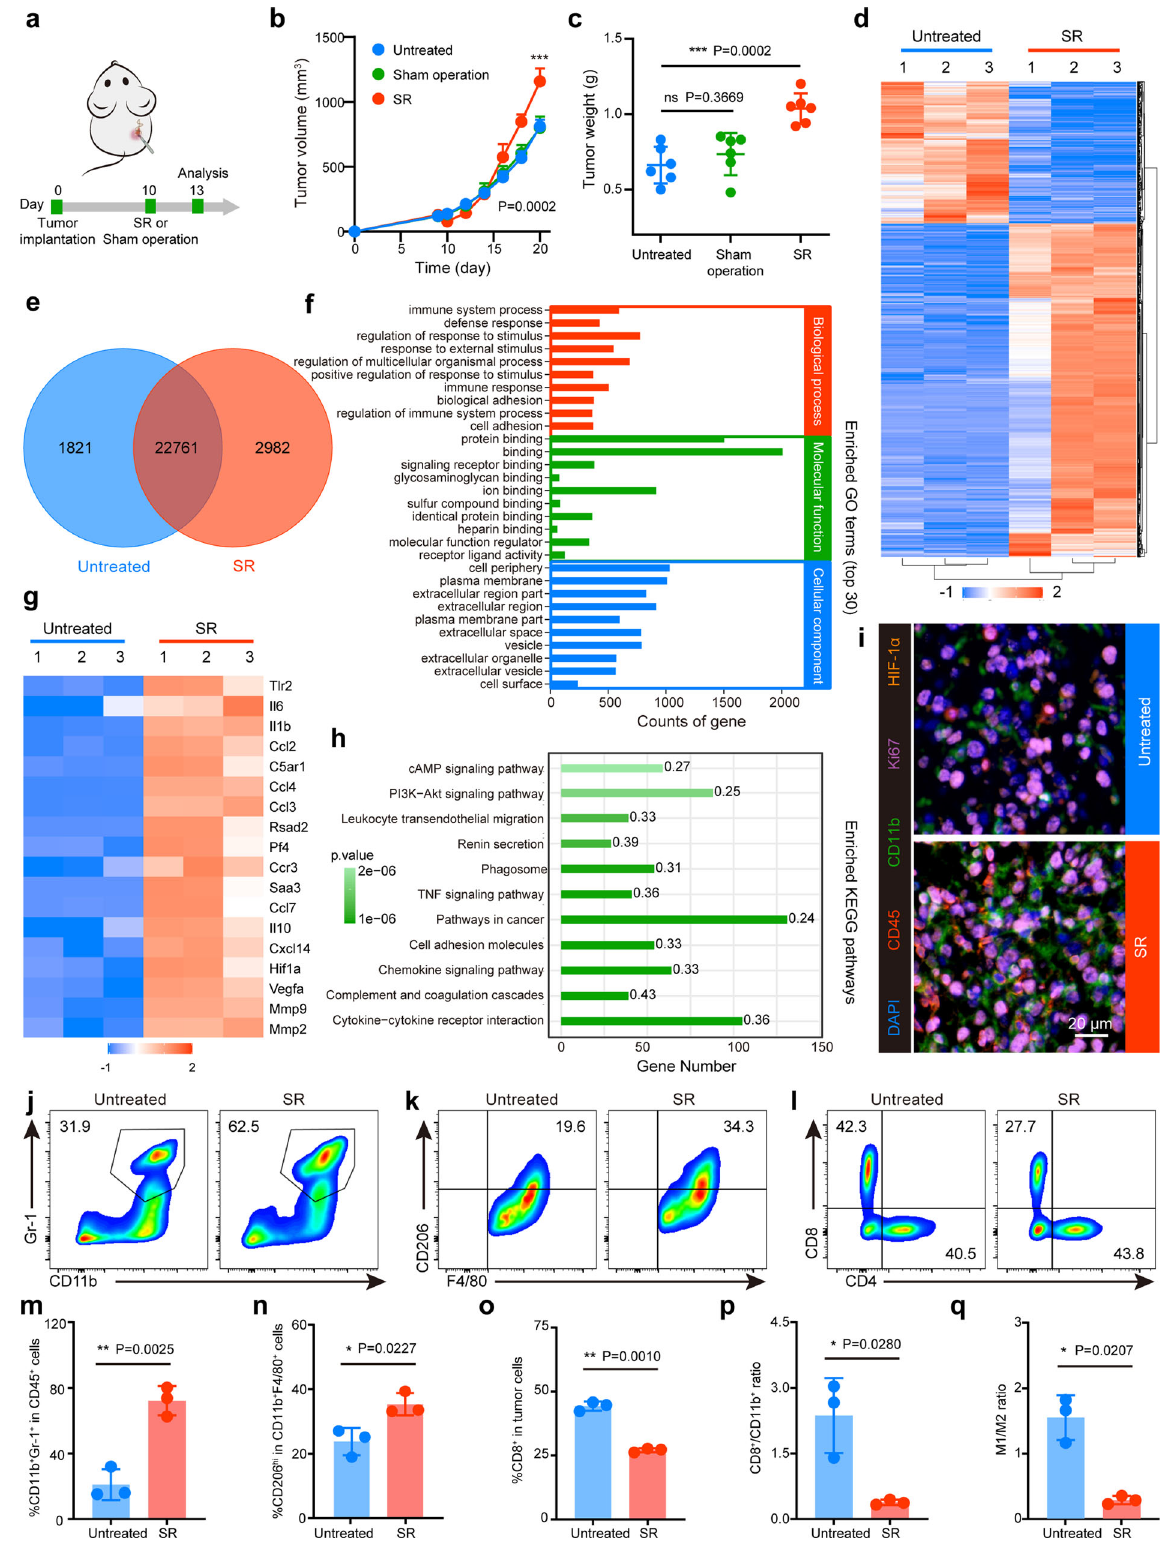
tissues compared with controls using immuno fl uorescence staining (Supplementary Fig. 4). Thus, we propose to use IPI549, a selective PI3K γ inhibitor con fi rmed in multiple tumor models 22,23 to reverse myeloid cell-mediated immunosuppres- sion, which in combination with RT that can cause ICD effect to trigger certain levels of antitumor immunity owing to